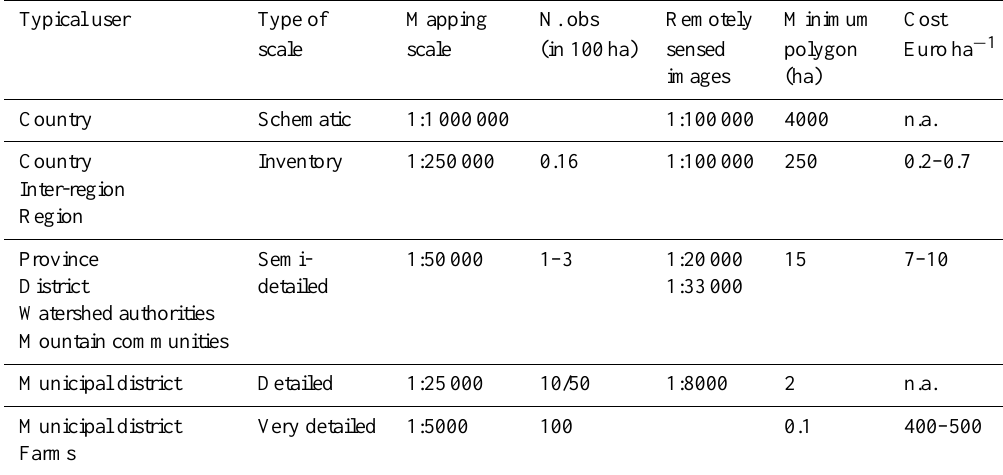
Table A1. Example of standards employed in soil survey and conventional soil mapping. Typical